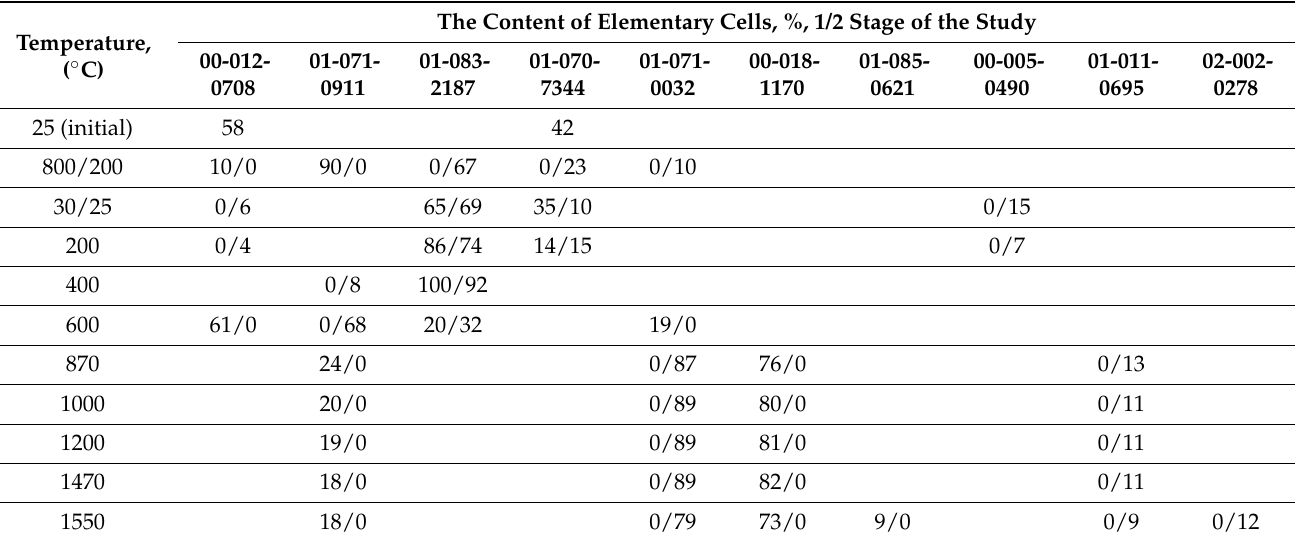
Table 4. The percentages of elementary cells characterized by the corresponding